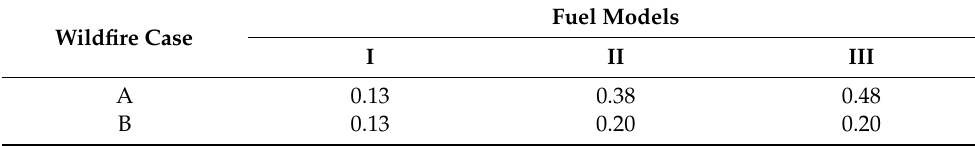
Table 3. Jaccard similarity coefficient for the three fuel models [28] used for the simulations. Wildfire